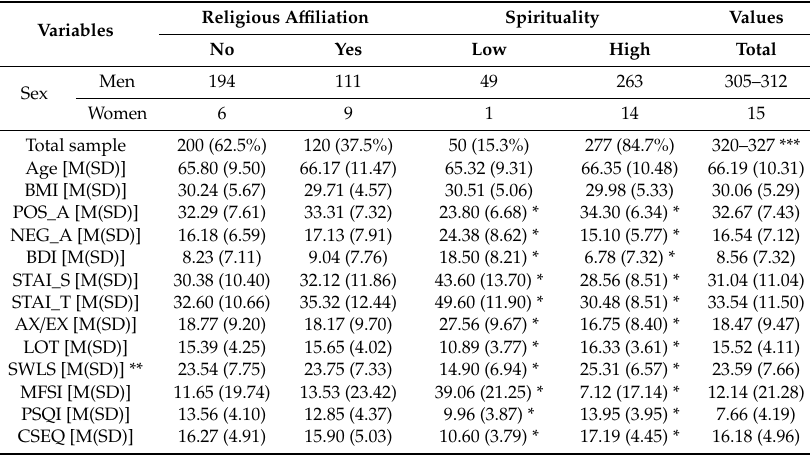
Table 2. Descriptive analysis of the